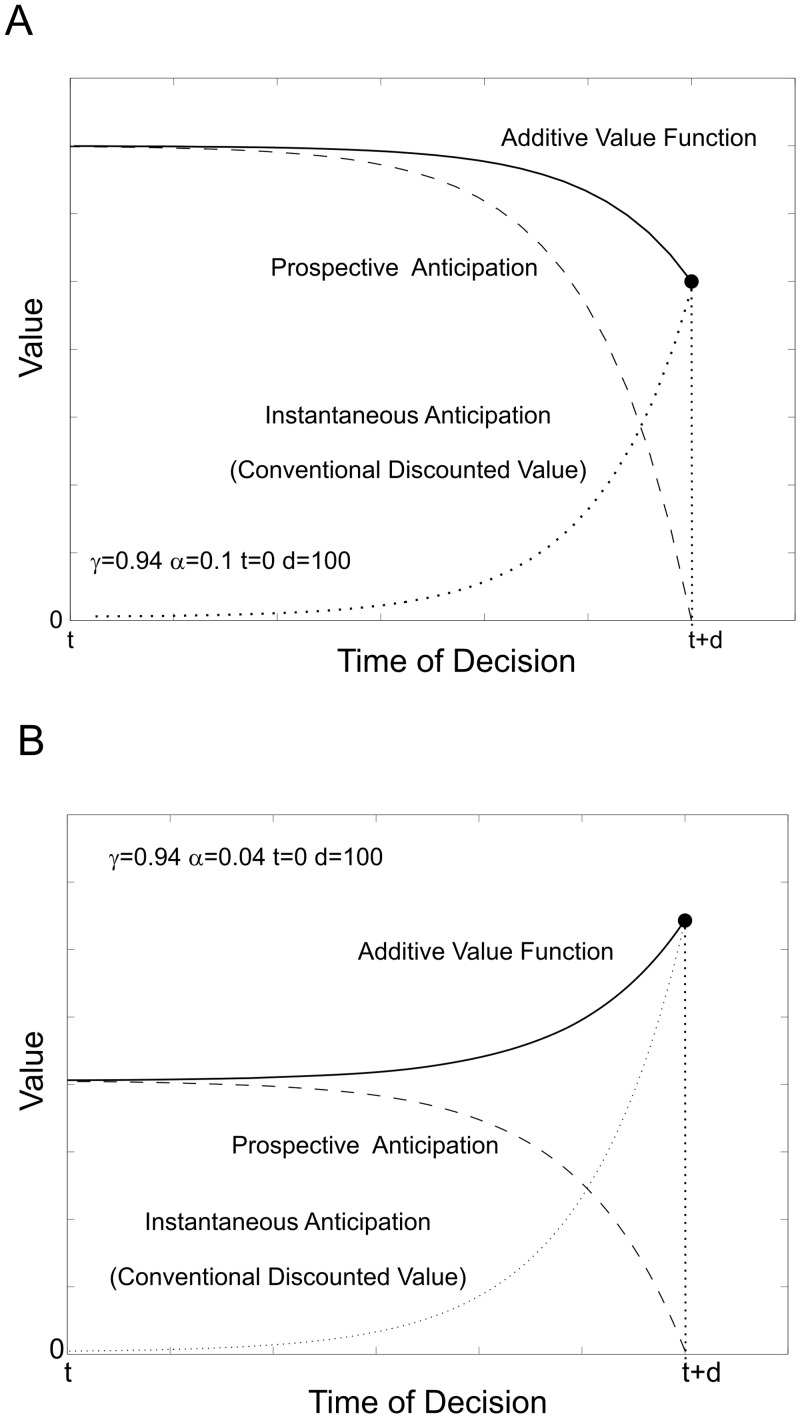
Anticipation-discounting functions.Anticipation-discounting functions are constructed from a linear combination of the conventionally discounted value of an outcome, i.e. its instantaneous anticipation, and the prospective sum of anticipation whilst waiting for the outcome, displayed here for an outcome with positive utility. A Where prospective anticipation (savoring) dominates, the overall value of the outcome decreases as it draws nearer, due to decreasing prospective anticipation. B Where discounting dominates, the overall value of the outcome increases as it draws nearer due to increasing instantaneous anticipation.